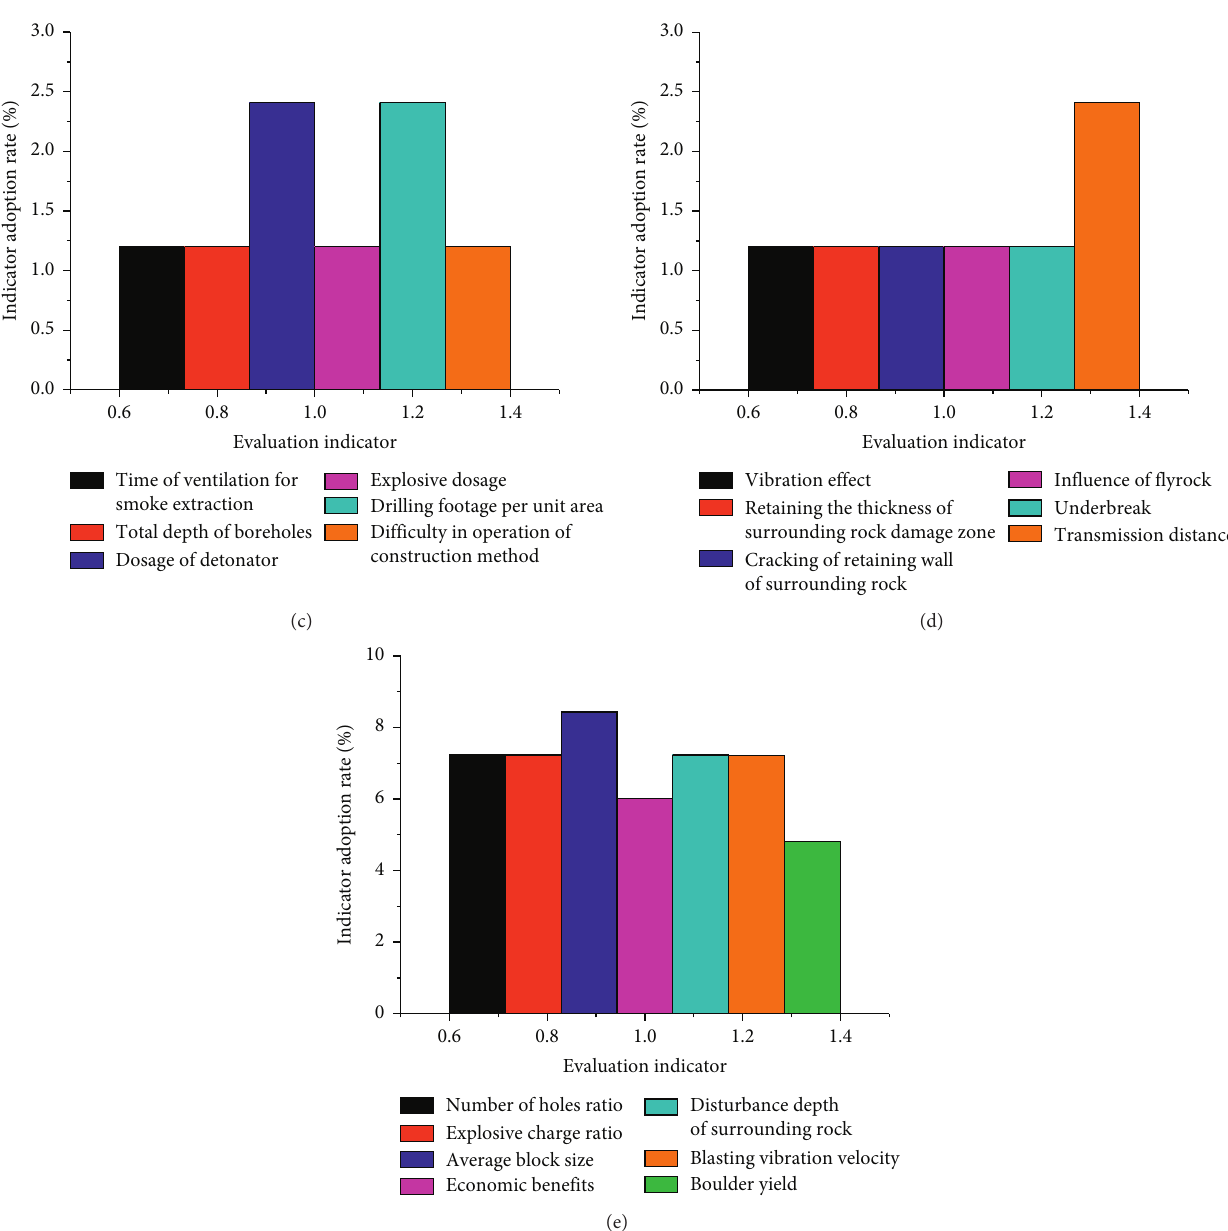
Figure 2: Statistical indices for quality rating of tunnel contour after smooth blasting in